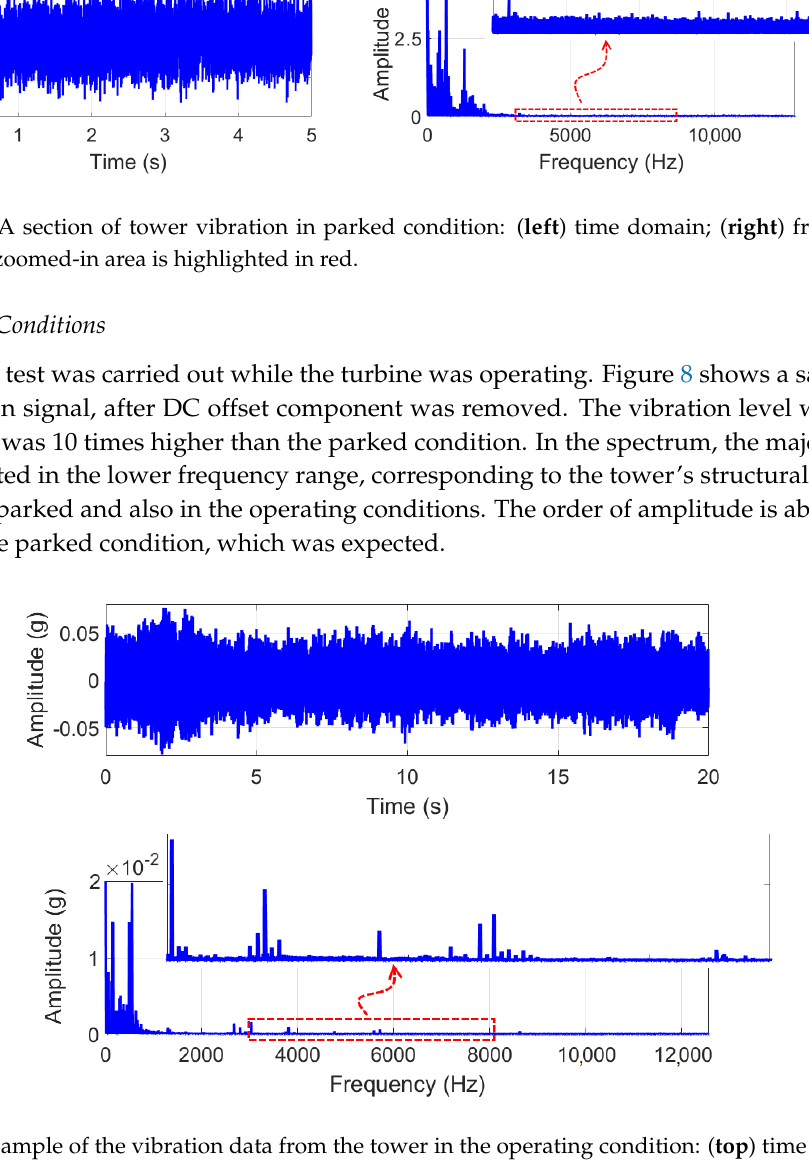
Figure 8. Sample of the vibration data from the tower in the operating condition: ( top ) time domain; ( bottom ) frequency domain- zoomed area is highlighted by